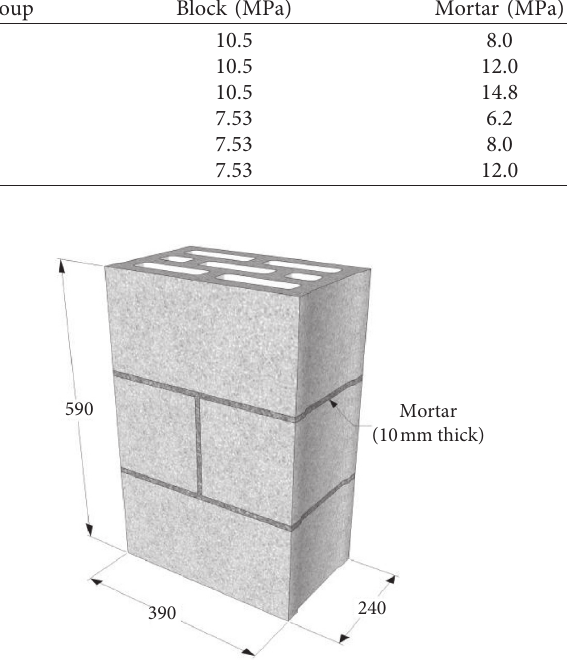
Figure 8: RCB masonry containing three rows of holes.